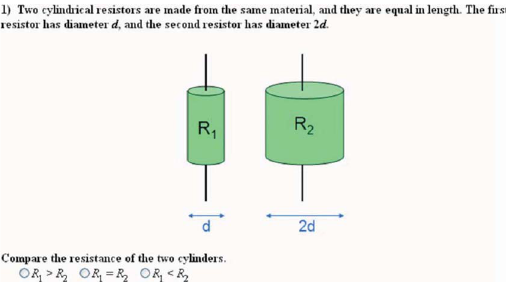
FIG. 4. (cid:1) Color (cid:2) Example of a preflight question. FIG. 5. (cid:1) Color (cid:2) Example of a